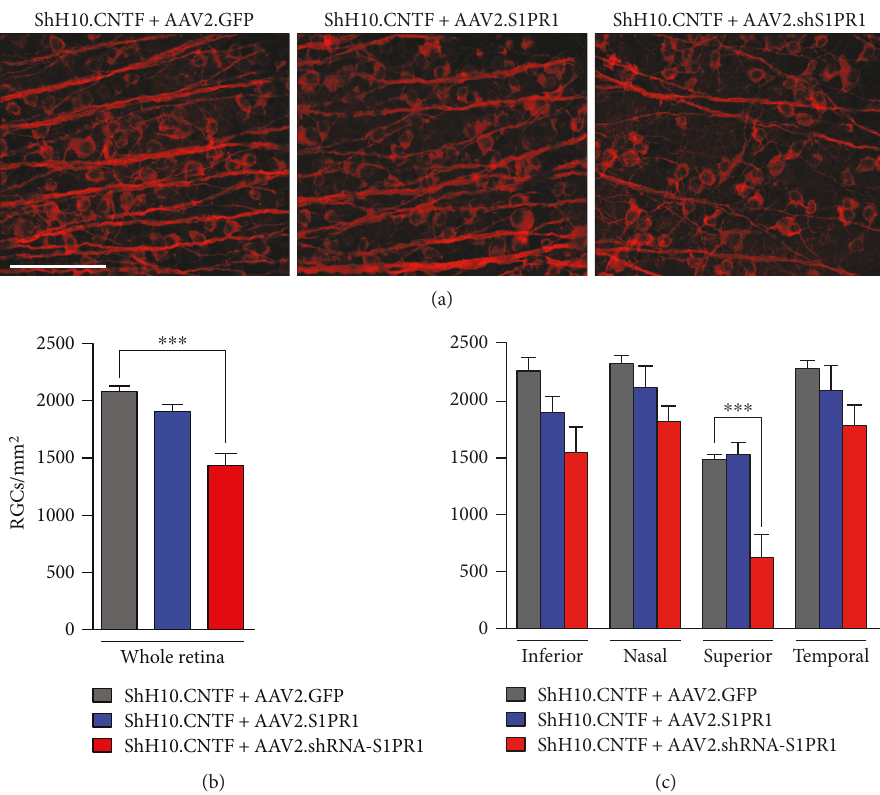
Figure 4: S1PR1 knockdown alters CNTF-induced RGC survival after ONC. (a) Two weeks after ONC, surviving RGCs were observed in retinal fl at-mounts after immuno fl uorescent staining for β 3-tubulin. Less RGCs were visible in retinae infected with AAV2.shRNA-S1PR1 and ShH10.CNTF ( n = 5 mice) than in mice injected with ShH10.CNTF/AAV2.GFP ( n = 7 mice) or ShH10.CNTF/AAV2.shRNA-S1PR1 ( n = 5 mice). (b) Quantitatively, the average number of surviving RGCs was statistically lower in whole retinae transduced with ShH10.CNTF/AAV2.shRNA-S1PR1 than in the two other groups of animals (ANOVA, ∗∗∗ p < 0 001 ). (c) The reduction of RGC survival caused by ShH10.CNTF/AAV2.shRNA-S1PR1 was the most pronounced in the superior quadrant of the retina (ANOVA, ∗∗∗ p < 0 001 ). Scale bar: 100 μ